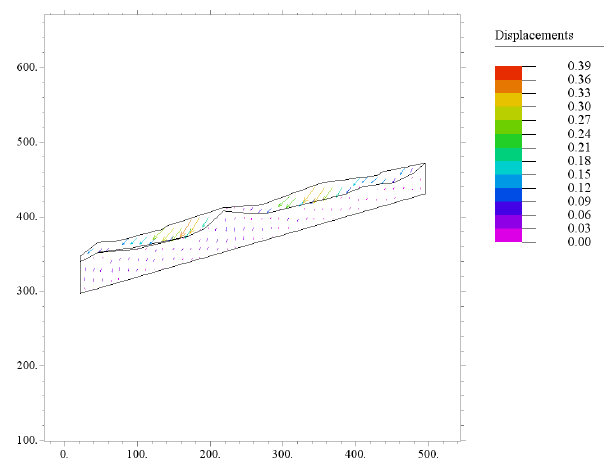
Figure 8. FEM numerical modelling, SoilVision software, Szymbark